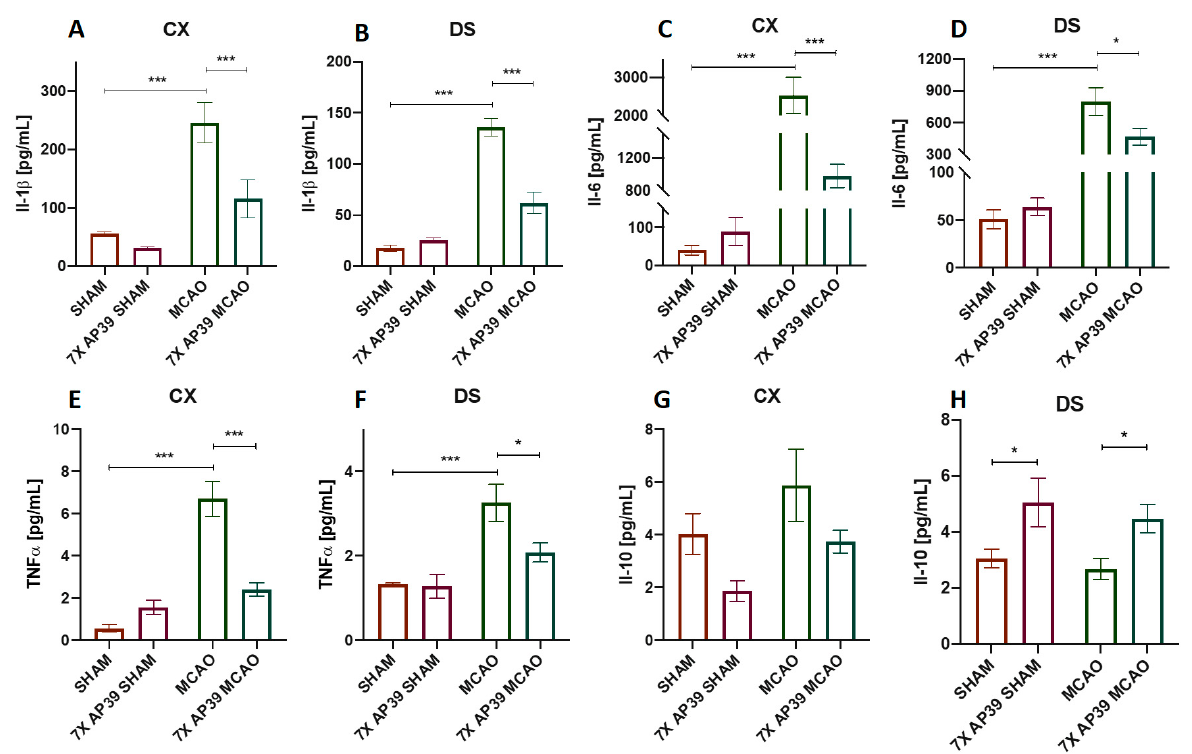
Figure 4. The effect of MCAO and AP39 on the protein expression level of the proinflammatory and anti-inflammatory cytokines in the frontal cortex (CX) and in the dorsal striatum (DS). ( A , B ) Relative Il-1 β levels in the CX and DS, respectively. ( C , D ) Relative Il-6 levels in the CX and DS, respectively. ( E , F ) Relative TNF α levels in the CX and DS, respectively. ( G , H ) Relative Il-10 levels in the CX and DS, respectively. n = 8, one-way ANOVA, followed by Sidak’s correction for post hoc comparisons, * p < 0.05 and *** p < 0.001 vs. MCAO or SHAM. Data are presented as the mean ± SEM.